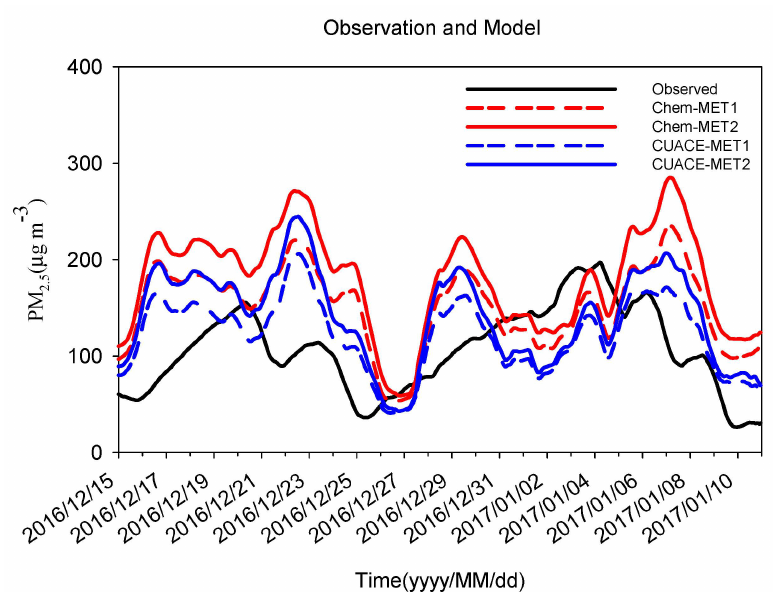
Figure 5. Time series of hourly the 24 h averages of the observed PM 2.5 concentration (unit: µ g m − 3 ) from 15 December 2016 to 11 January 2017 (solid black line) and simulated PM 2.5 concentration from the four groups of tests (red dotted line: Chem-MET1; red solid line: Chem-MET2; blue dotted line: CUACE-MET1; blue solid line: CUACE-MET2) (unit: µ g m − 3 ).